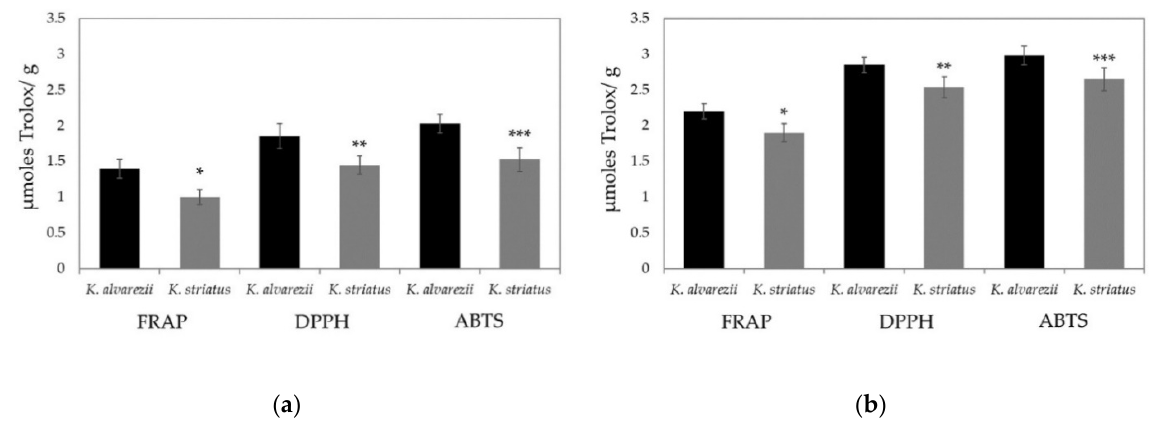
Figure 5. Total soluble ( a ) and fat-soluble antioxidant ( b ) capacities in K. alvarezii and K. striatus determined by FRAP, DPPH and ABTS assays. Data are represented as the mean ± SD ( n = 36 for each year). Results were analyzed via Mann–Whitney U test: significant difference ( p < 0.05) of soluble and fat-soluble antioxidant capacities obtained via FRAP (*), DPPH (**) and ABTS (***) test in K. alvarezii versus K. striatus.